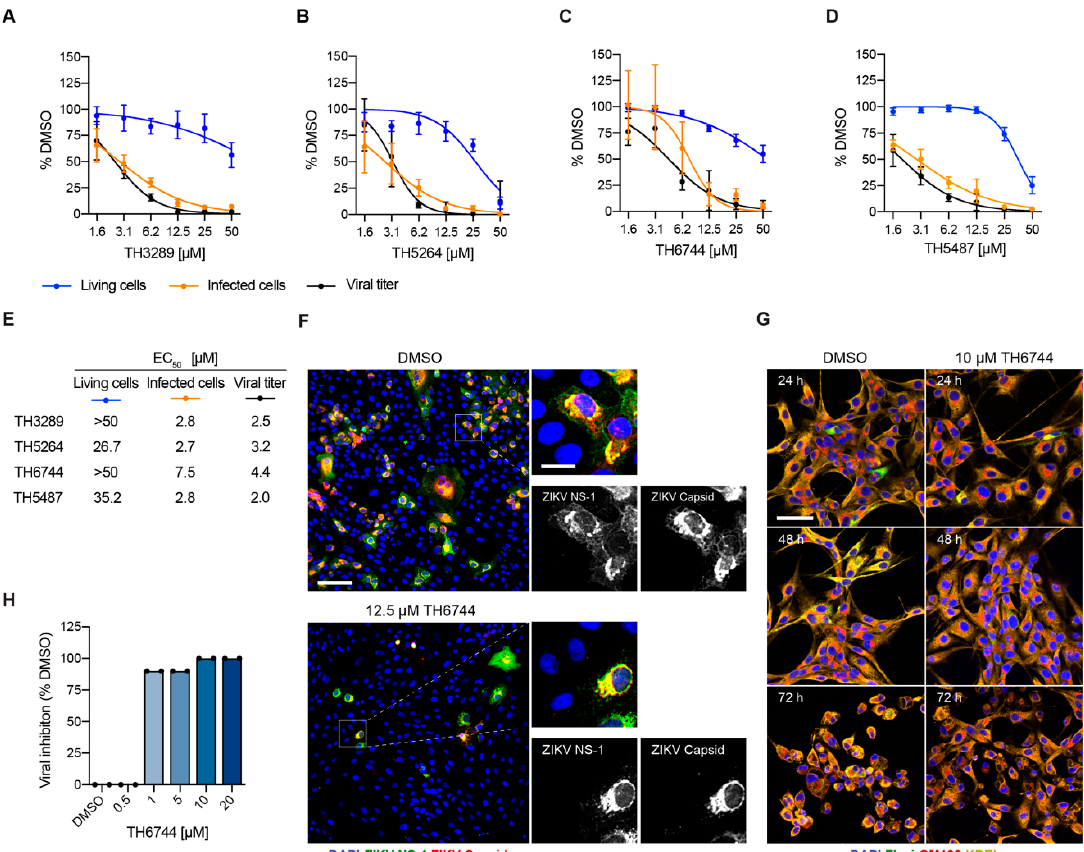
Figure 2. Series of antiviral compounds have a therapeutic window and rescue ZIKV-induced CPE in cellular models. ( A – E ) U87 cells were infected with ZIKV (MOI 1) and treated with increasing doses of ( A ) TH3289, ( B ) TH5264, ( C ) TH6744, or ( D ) TH5487 for 48 h. Cell viability was determined by nuclei count (in blue), infected cells by ZIKV NS1 staining (in orange) and virus titer by an end-point dilution assay (in black). Data are presented as mean ± SD from n = 3 independent replicates. ( E ) Curve fitting was performed to calculate EC 50 values for living cells, infected cells and viral titer. ( F ) Vero cells were infected with ZIKV (MOI 10) and treated with 12.5 µ M TH6744 or DMSO for 48 h. Cells were stained for ZIKV NS1 (in green), ZIKV Capsid (in red) and DAPI (in blue). Images of n = 1 biological replicate. In the overview image, scale bar equals 100 µ m and in the close-up 25 µ m. ( G ) U87 cells were infected with ZIKV (MOI 1) and treated with 10 µ M TH6744 or DMSO for 24, 48, or 72 h. Cells were stained for Pan-Flavi (in green), Golgi marker GM130 (in red), ER marker KDEL (in yellow), and DAPI (in blue). Images of n = 1 biological replicate. Scale bar equals 50 µ m. ( H ) Vero cells were infected with ZIKV (MOI 0.1) and treated with increasing doses of TH6744 for 24 h. Viral titer was measured from the supernatants by end-point dilution assay on Vero cells and the development of CPE were monitored by visual assessment. Data presented as mean ± SD from n = 2 biological